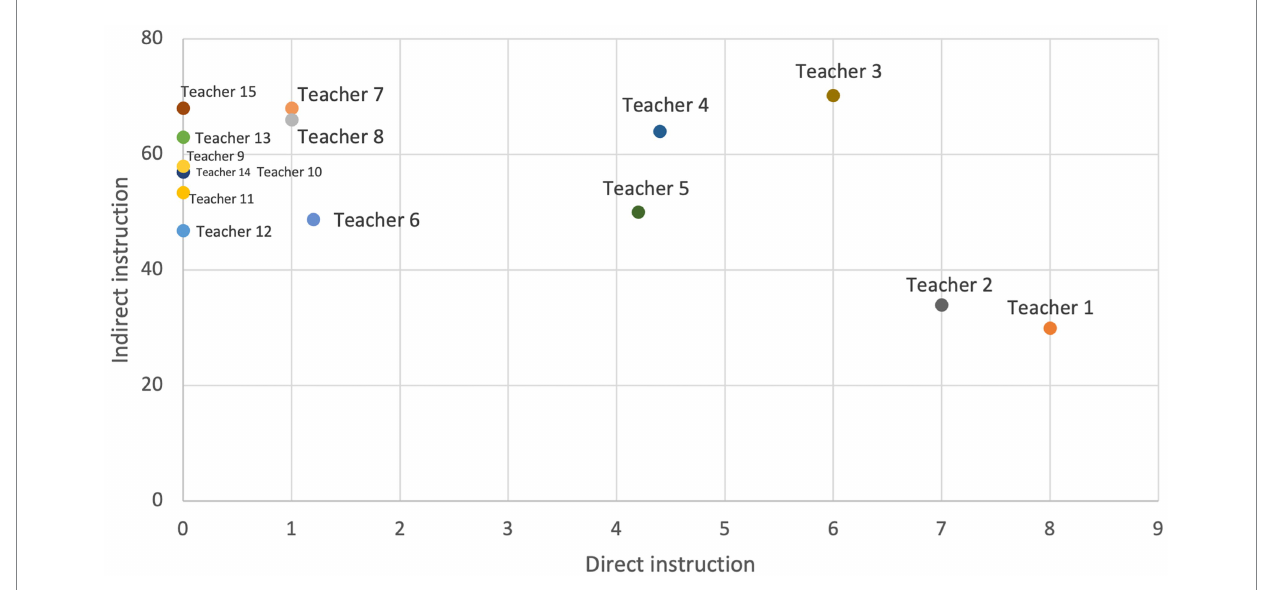
FIGURE 1 Direct and indirect strategy instruction by